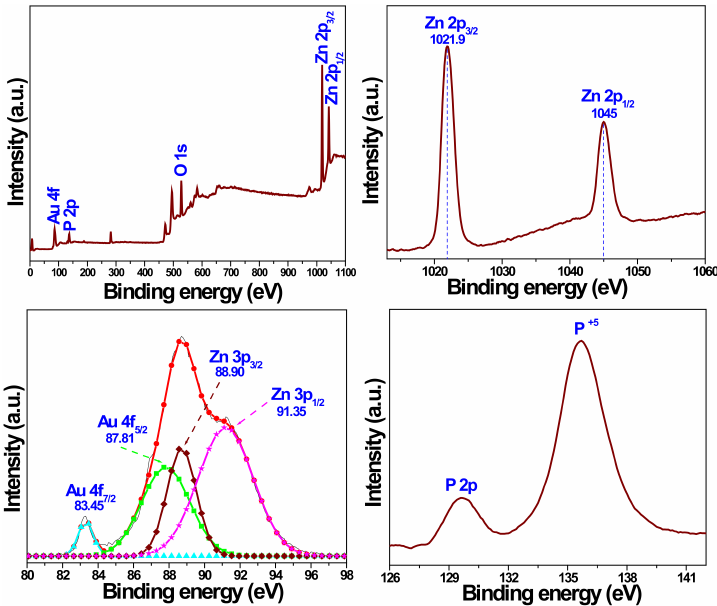
Figure 3. XPS spectra of the AZB nanocomposite. ( a ) Survey spectrum illustrating the presence of constituent elements in the analyzed sample. ( b ) Zn 2p peaks. ( c ) Gaussian-fitted curves obtained for the Zn 3p and Au 4f peaks. ( d ) P 2p core peaks.